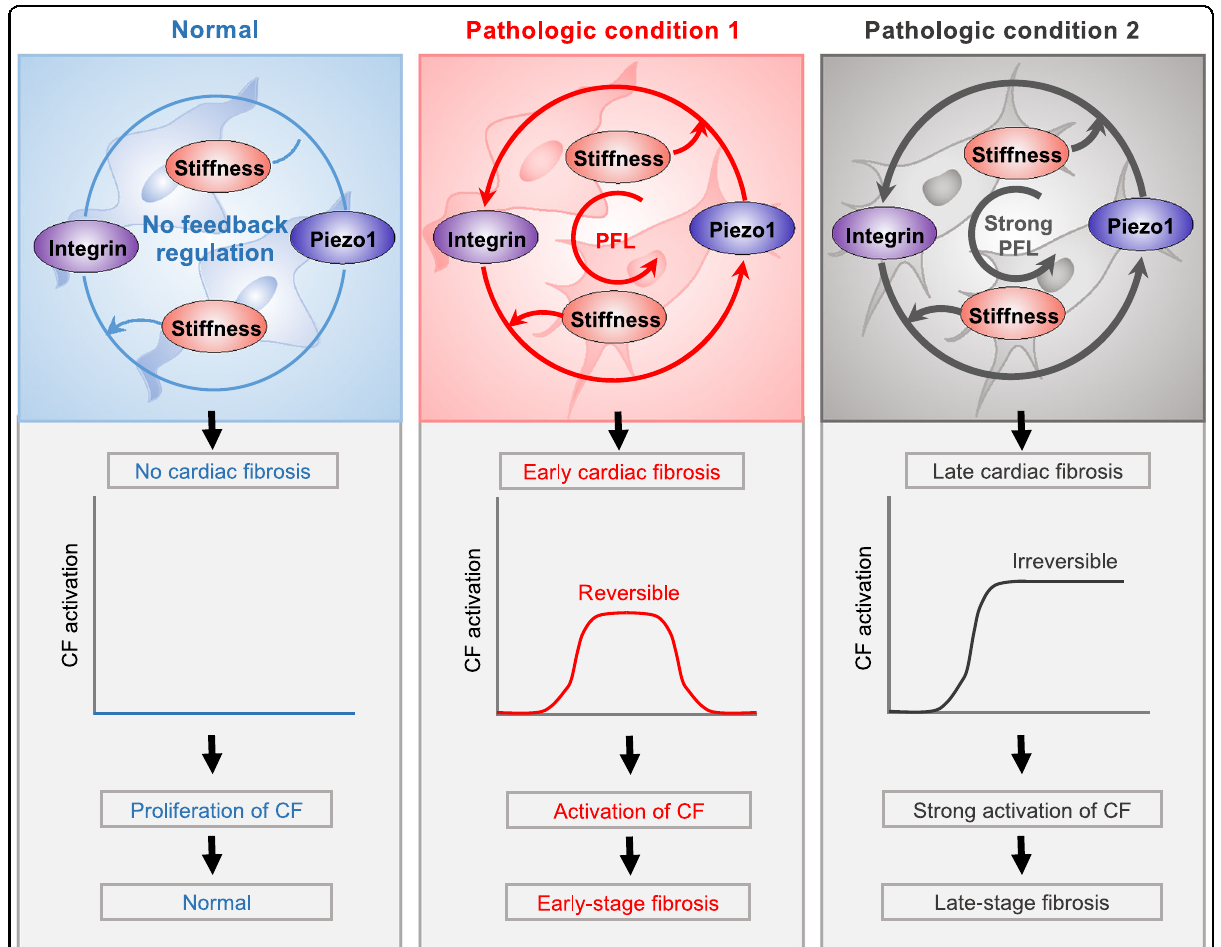
Fig. 6 Proposed mechanical PFL, mediated by Piezo1 and integrin β 1, that contributes to irreversible CF phenotype. The integrin β 1-Piezo1 PFL suggests clues for understanding fi broblast activation during the development of myocardial infarction and fi brotic disease. A bistable switch can be turned on under pathologic conditions by stiffness-mediated activation of the PFL, eventually resulting in irreversible activation of fi broblasts as the disease